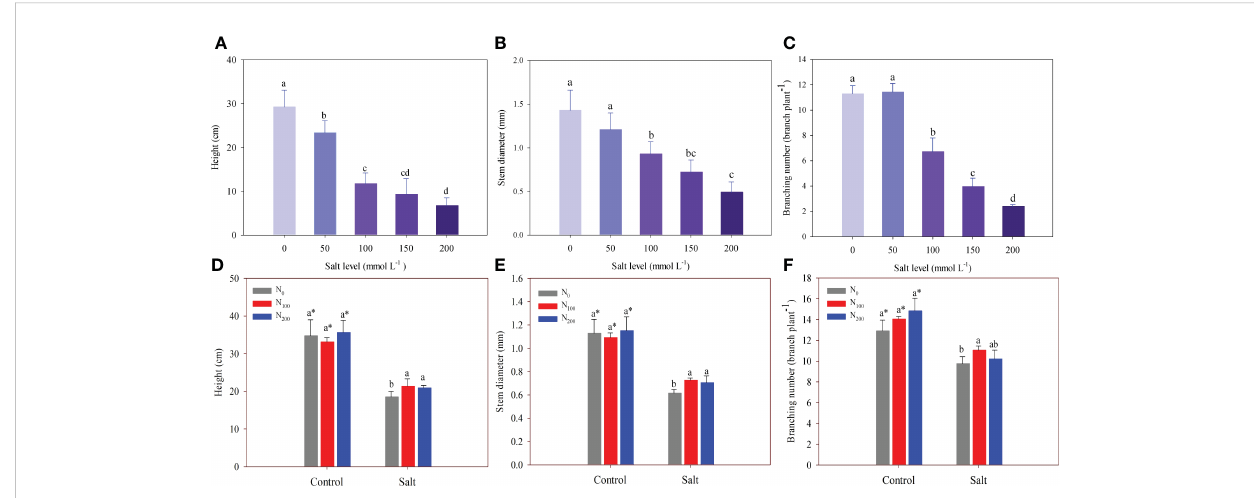
FIGURE 1 Alfalfa height (A) , stem diameter (B) , and branching number (C) in different salt levels in experiment 1. Alfalfa height (D) , stem diameter (E) , and branching number (F) in different nitrogen (N) supply and salt levels in experiment 2. Error bars represent ± SD of the mean. Different letters represent a signi fi cant difference among treatments ( p ≤ 0.05). Asterisks refer to signi fi cant differences between salt levels at the same N fertilizer supply